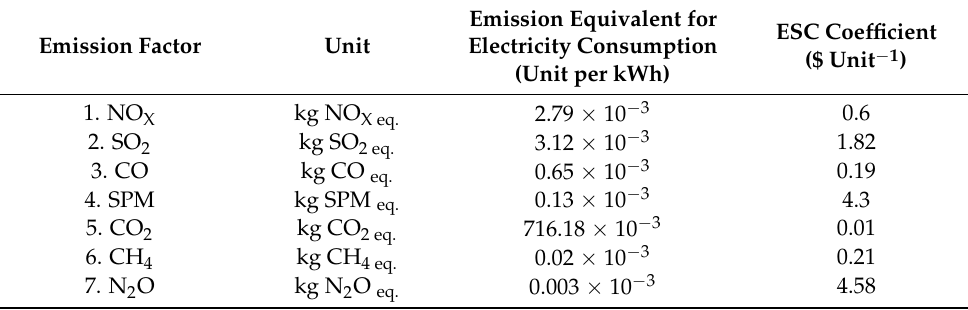
Table 2. ESC coefficients for production of mushroom in Isfahan province, Iran.